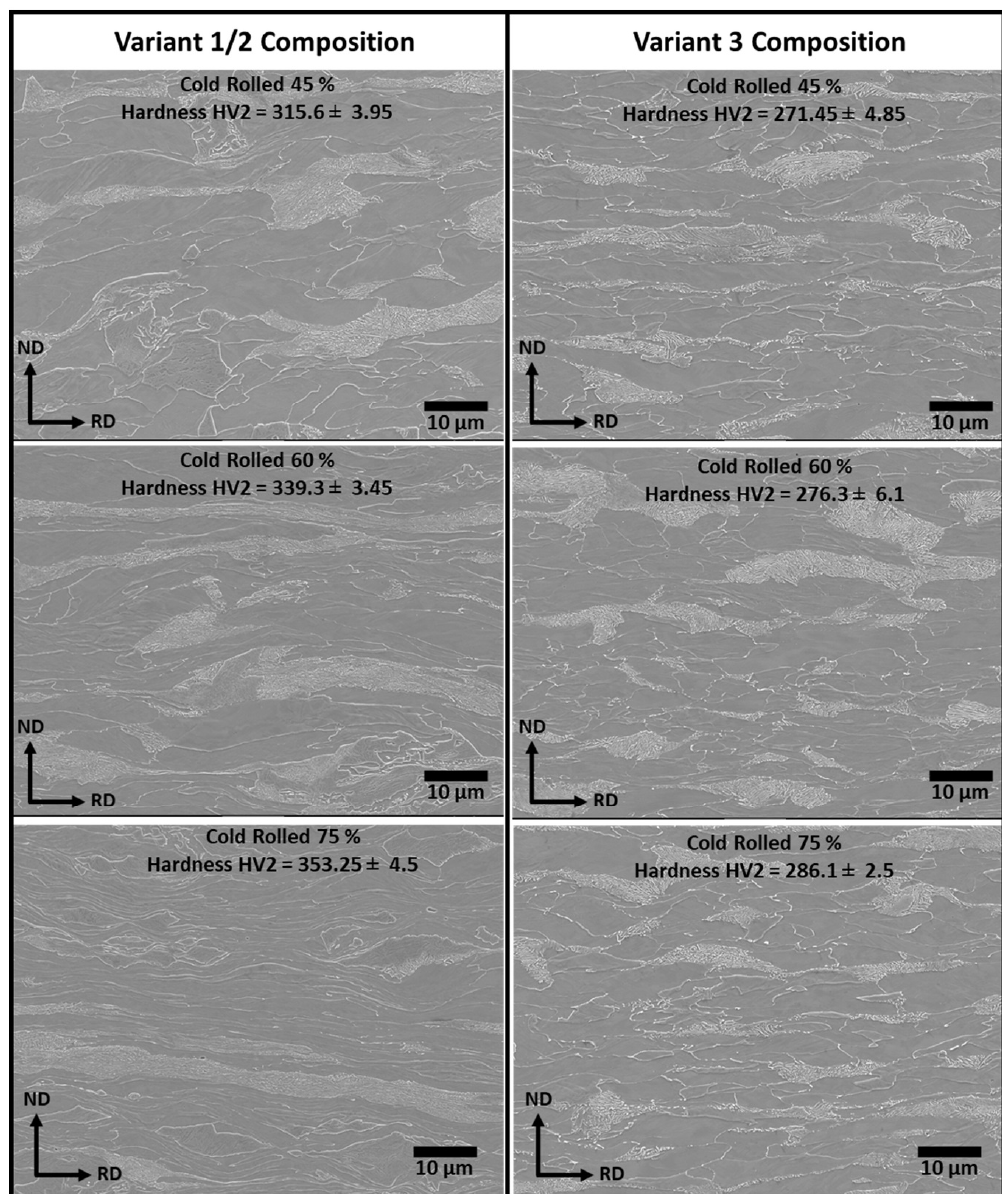
Figure 12. SEM micrographs of the cold rolled 45%, 60% and 75% samples for the Variant 1/2 com- position and Variant 3 composition steels. tion and Variant 3 composition